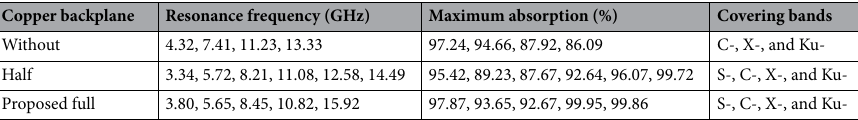
Table 6. Effect of copper backplane on absorption peaks and frequencies.